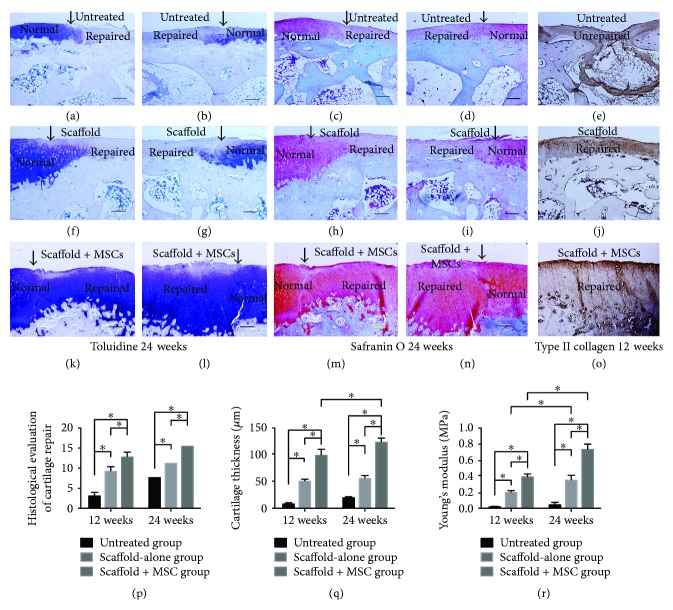
Toluidine blue, safranin O, and immunohistochemical staining of the collagen type II content of repaired cartilage at 24 weeks postimplantation (a–o). (a) and (e) The defect in the untreated group was filled with fibrotic tissue but did not stain for cartilage-specific matrix. (f) and (j) The defect region was filled with repaired cartilage, with light staining for cartilage-specific matrix. (k) and (o) The cartilage defect was filled with regenerated cartilage, and the deep regenerated area stained strongly for cartilage-specific matrix. (p–r) The histological grading, cartilage thickness, and Young's modulus, respectively, of repaired cartilage at 12 and 24 weeks postsurgery (bars: 50 μm). ∗P < 0.05.